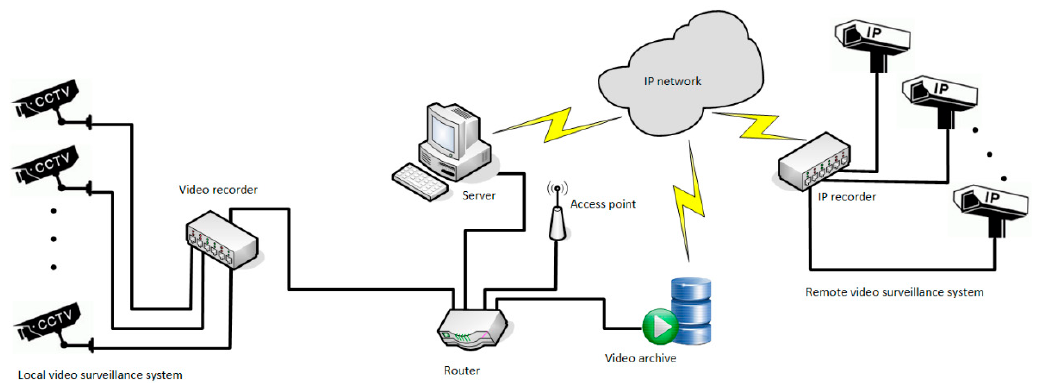
Figure 8. Diagram of a system supporting the process of making operational decisions of the MTC system. Source: own study.